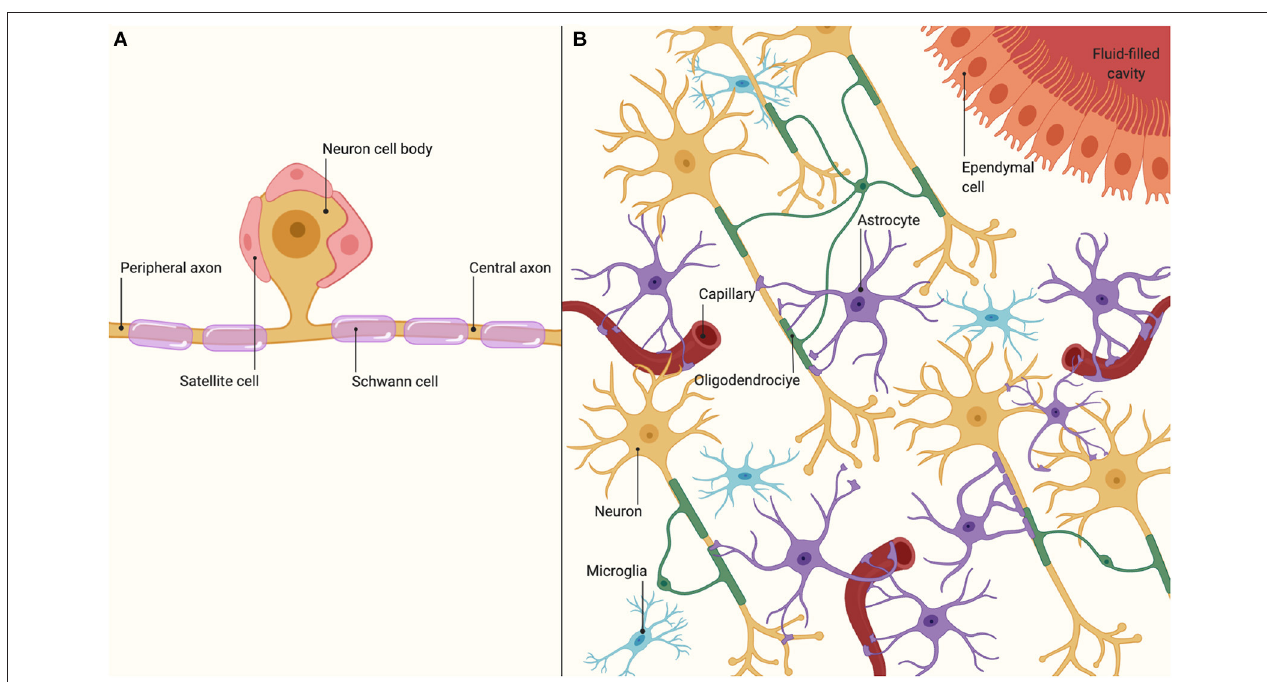
FIGURE 2 | Nervous system cell organization. (A) Cells and organization in the peripheral nervous system. (B) Cells and organization in the central nervous system.